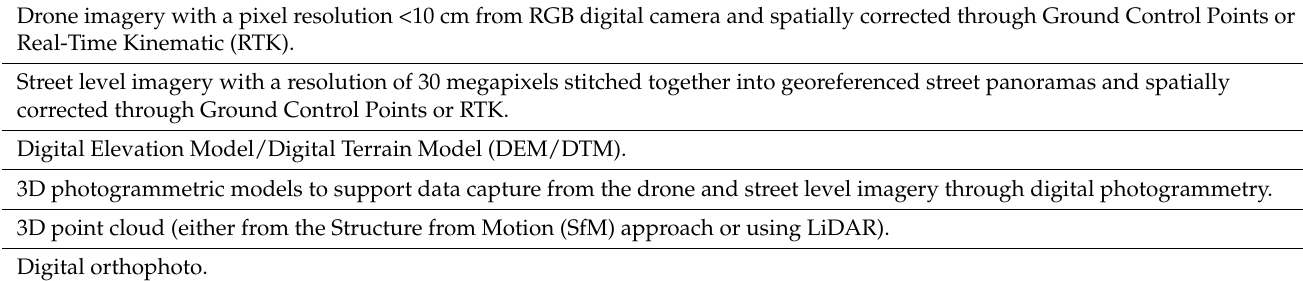
Table 2. Elements of Common Set of Geospatial